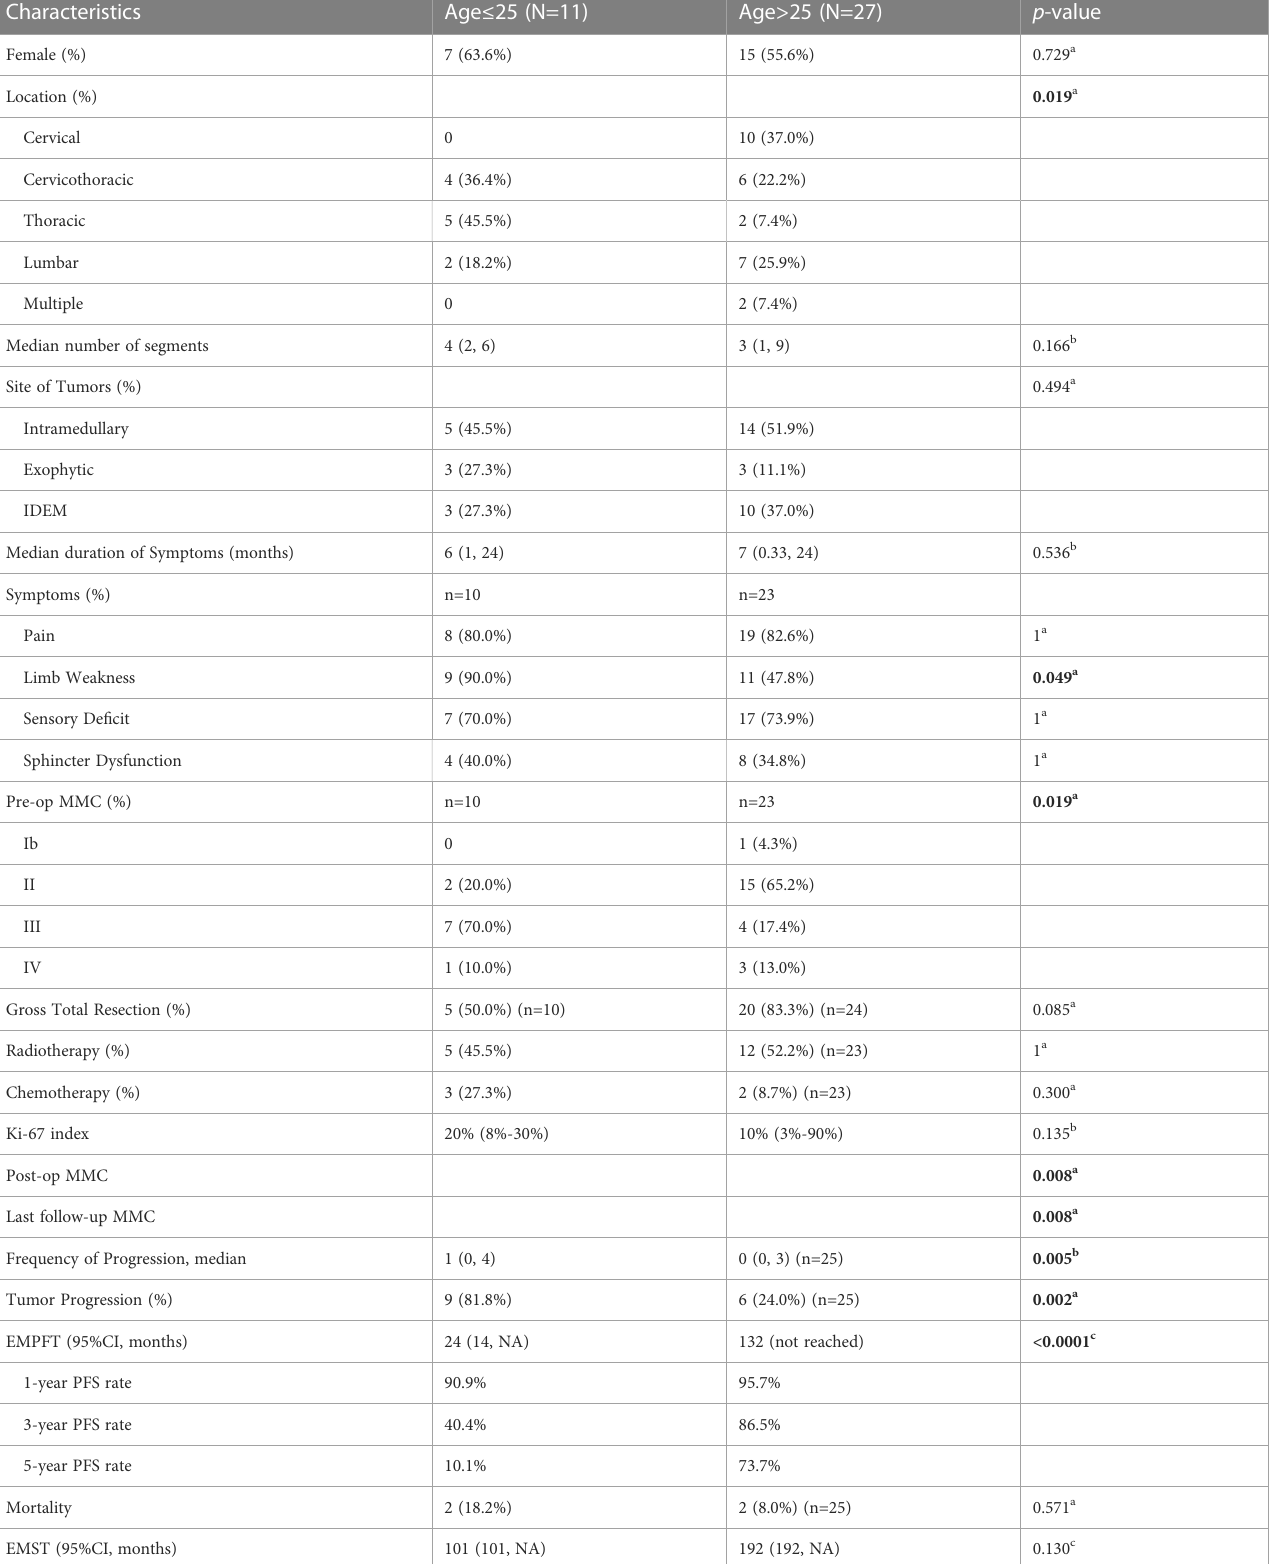
TABLE 2 Characteristics of primary spinal anaplastic ependymoma in patients above and below